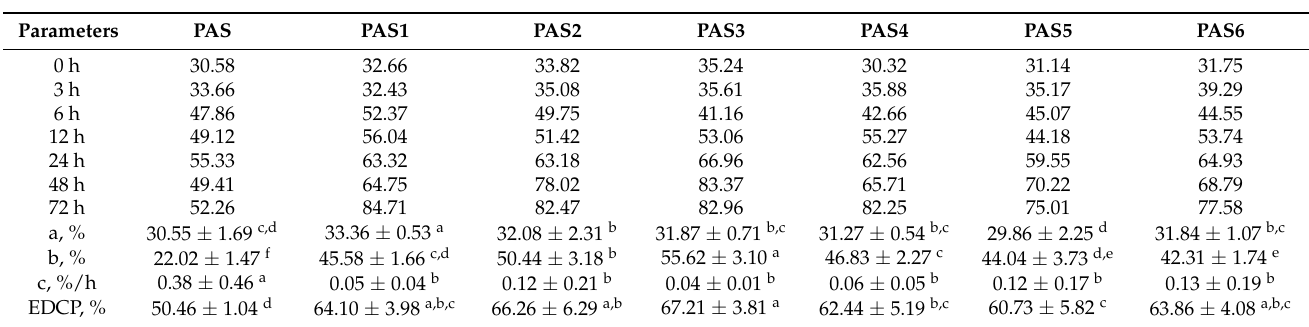
Table 6. Percentage crude protein disappearance at different incubation periods and the effective degradability of crude protein of in vitro-incubated pineapple waste silage with or without prote- olytic